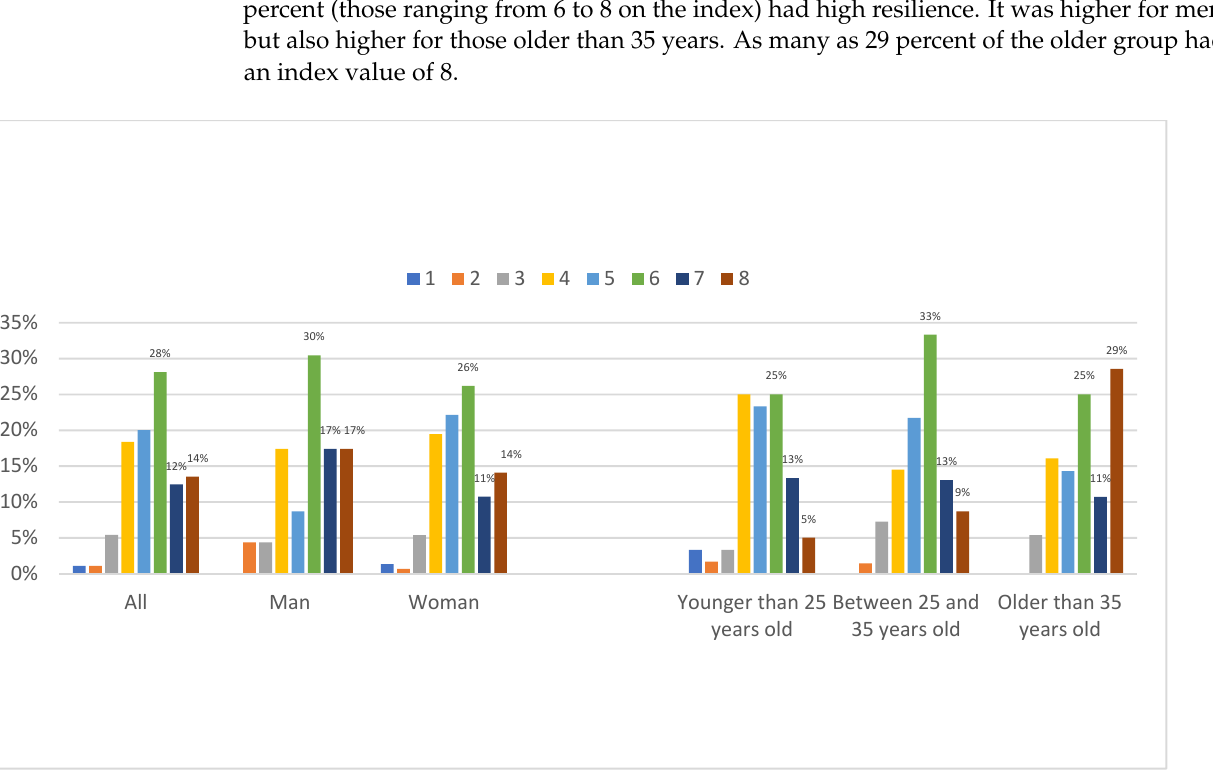
Figure 1. Resilience (CD-RISC 2), by gender and age group, by percentage. (Note. Scaling from 0 ‘Not true at all’ to 8 ‘True nearly all the time’).